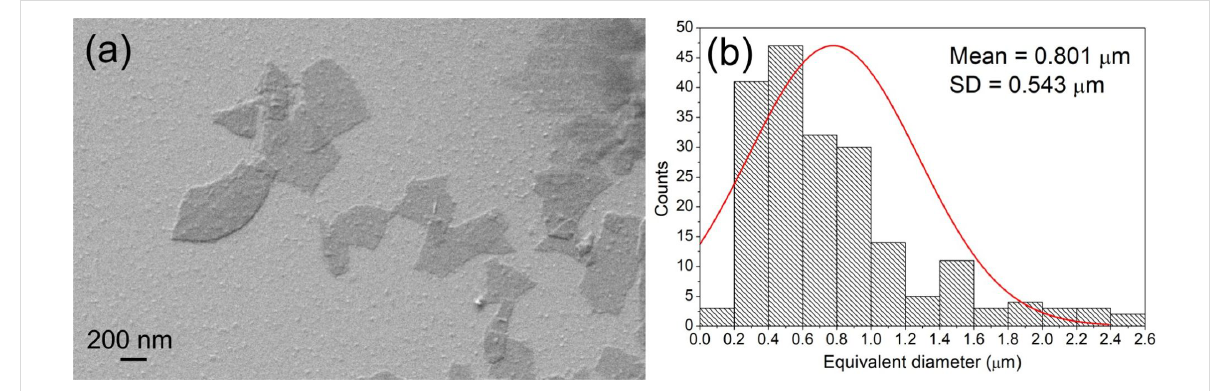
Figure 1: (a) SEM image of graphene oxide flakes, (b) the equivalent diameter distribution of the GO flakes obtained by SEM.